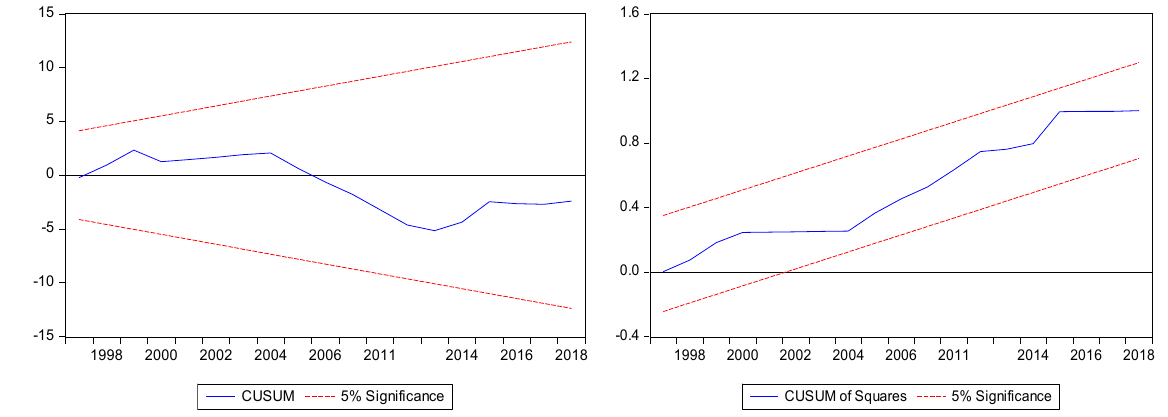
Figure 4. ARDL CUSUM and CUSUM of